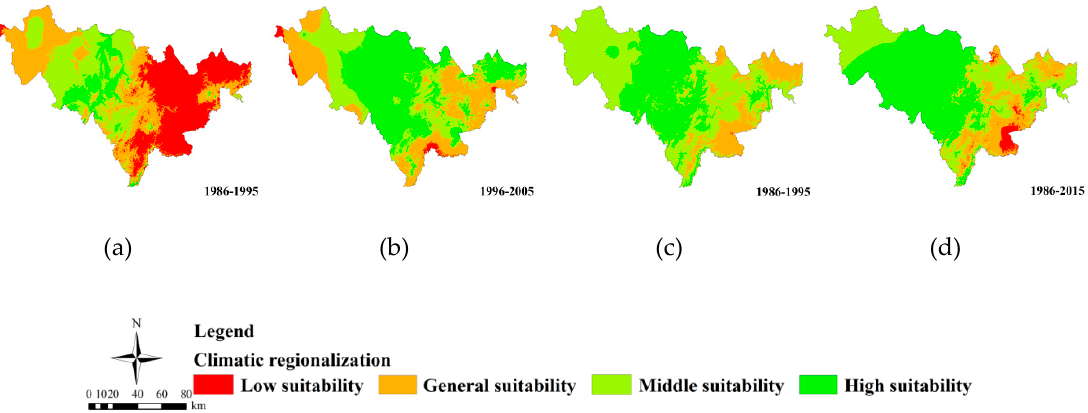
Figure 8. Spatial distribution of climate suitability ( a – d ).